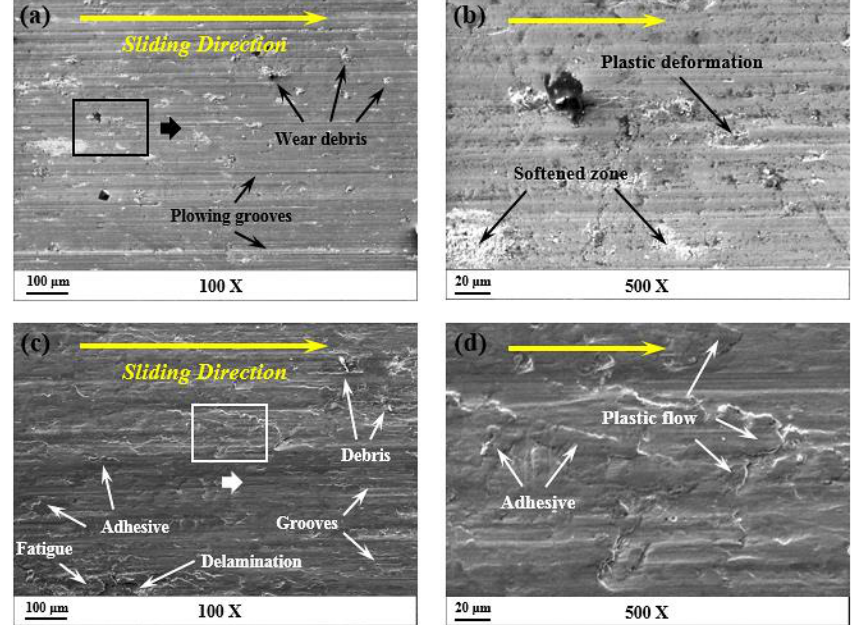
Figure 8. The worn surface morphologies of the HCCI under different loads: ( a ) 300 N-low magnification; ( b ) 300 N-high magnification; ( c ) 900 N-low magnification; ( d ) 900 N-high magnification.